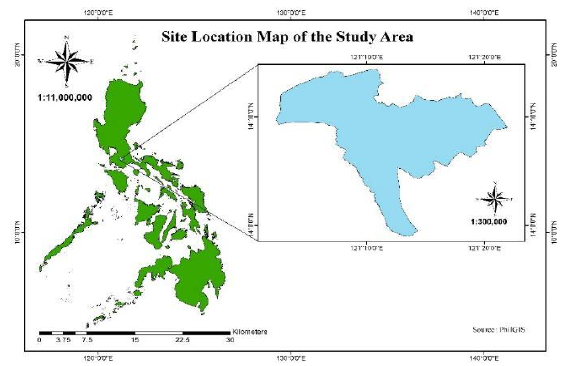
Figure 1. Site location map of the study area